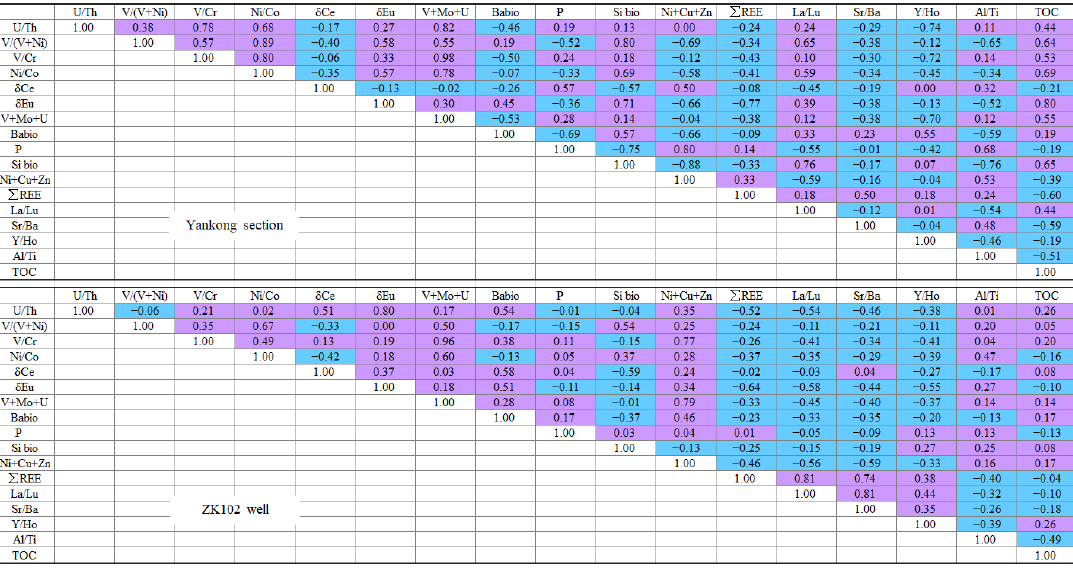
Figure 14. Correlation coefficients of TOC content with various geochemical proxies (Purple mean positive correlation, and blue mean negative correlation).